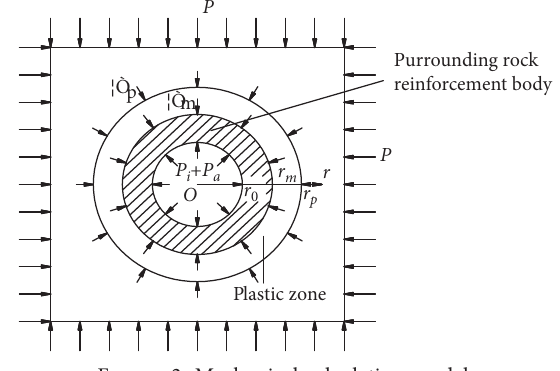
Figure 2: Mechanical calculation